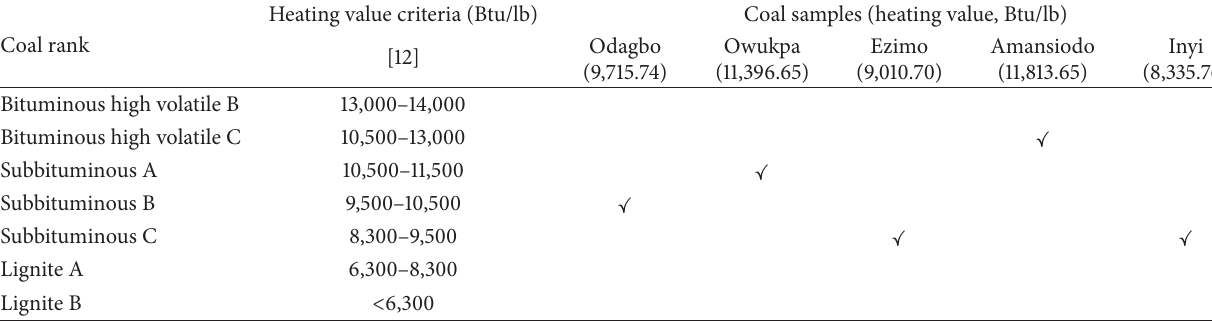
Table 8: Ranking of five coal samples using the ASTM classification.